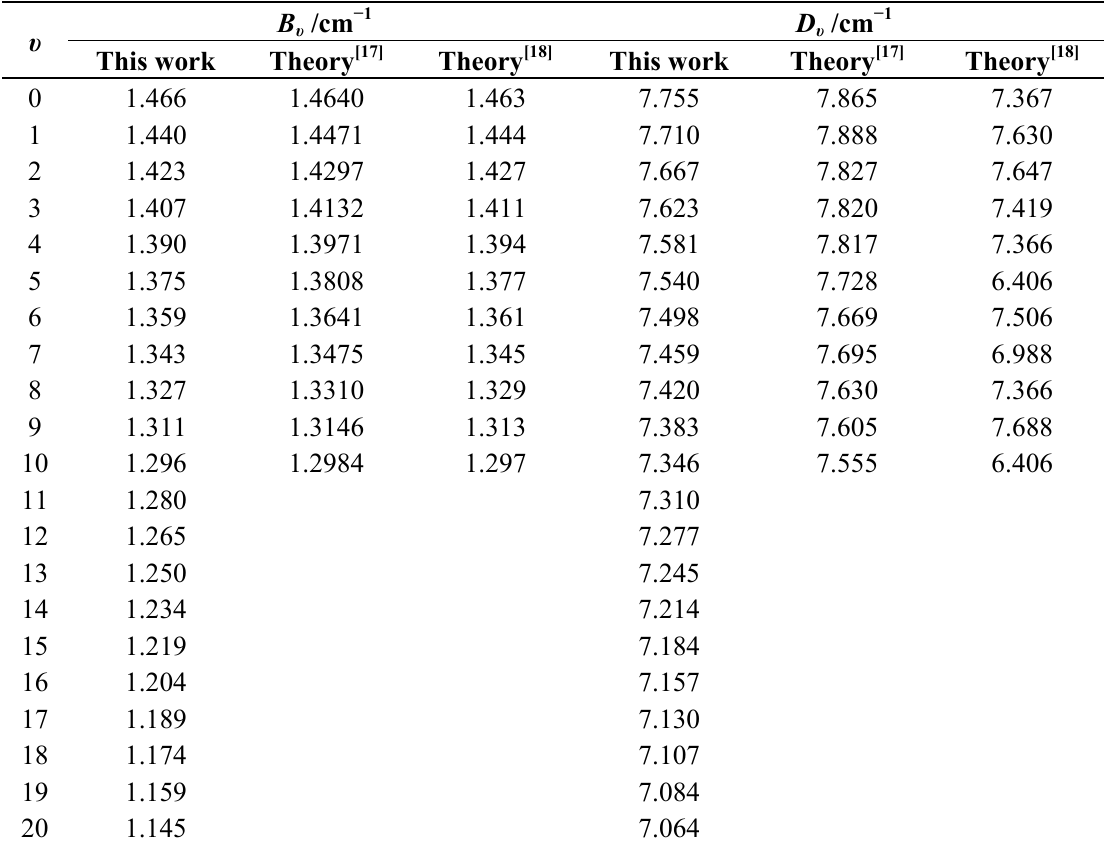
Table 4. Rotational constants for BeF(X 2 Σ + )